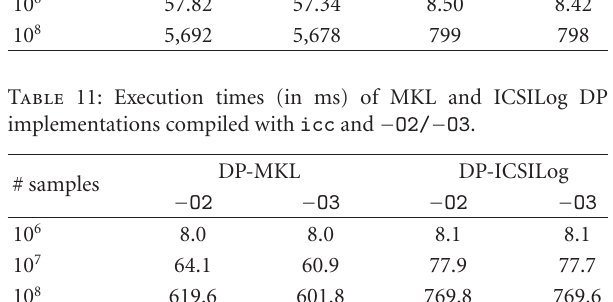
Table 9: Execution times (in ms) of MKL, ICSILog, LAU, and VLAU DP implementations (The icc compiler is used.)